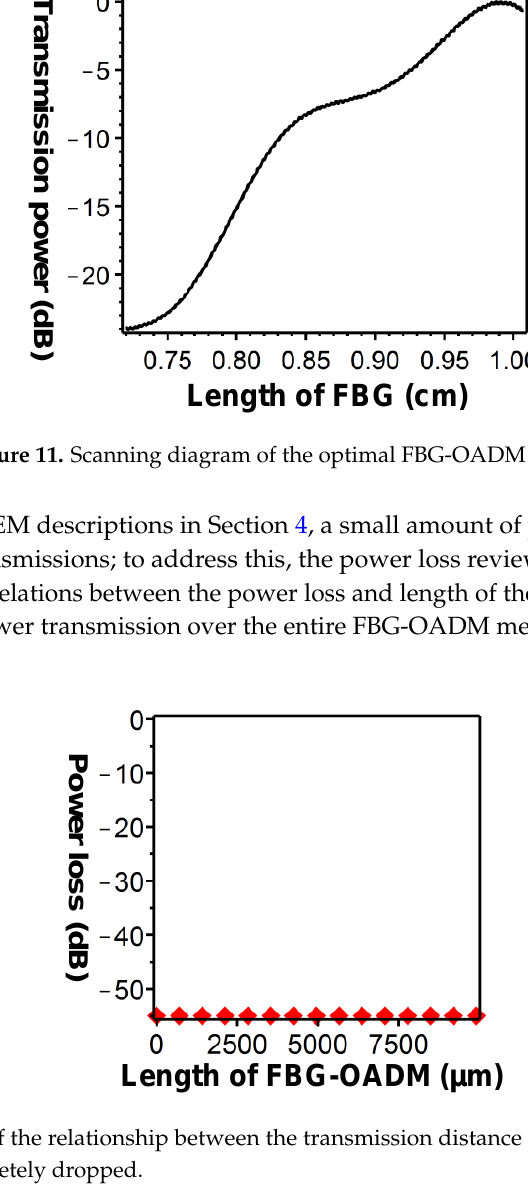
Figure 10. Scanning diagram of the optimal Λ FBG .